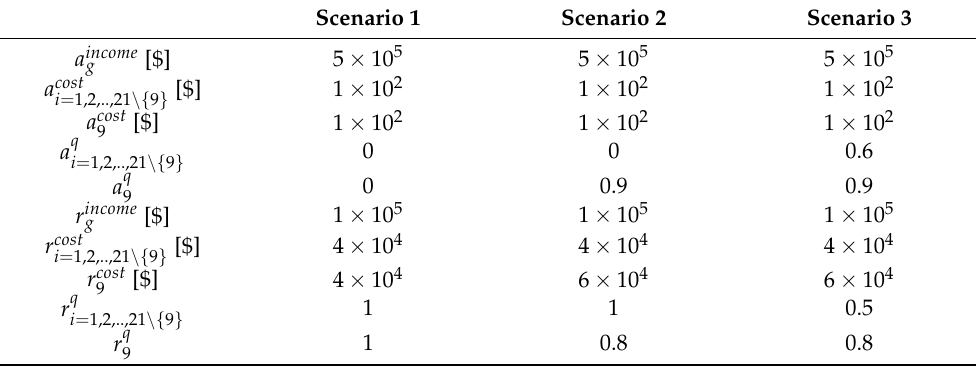
Table 3. Assumed values of aspirations and reservations taken for different